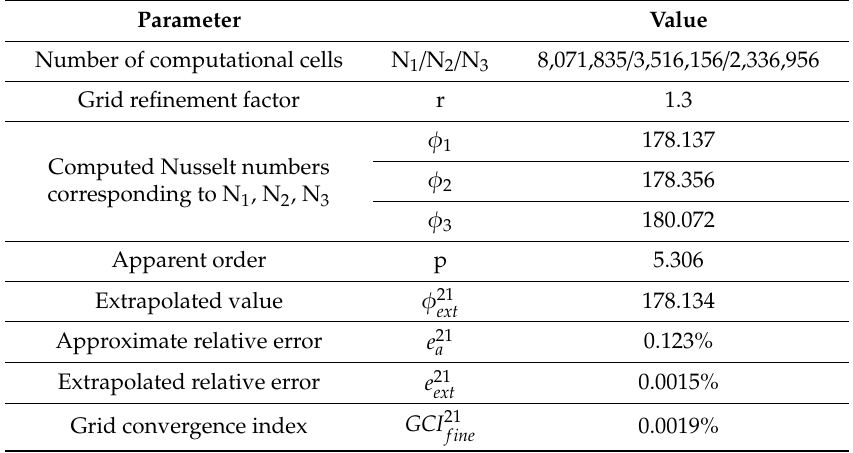
Table 1. Results of grid convergence index (GCI) analysis using Richardson extrapolation.